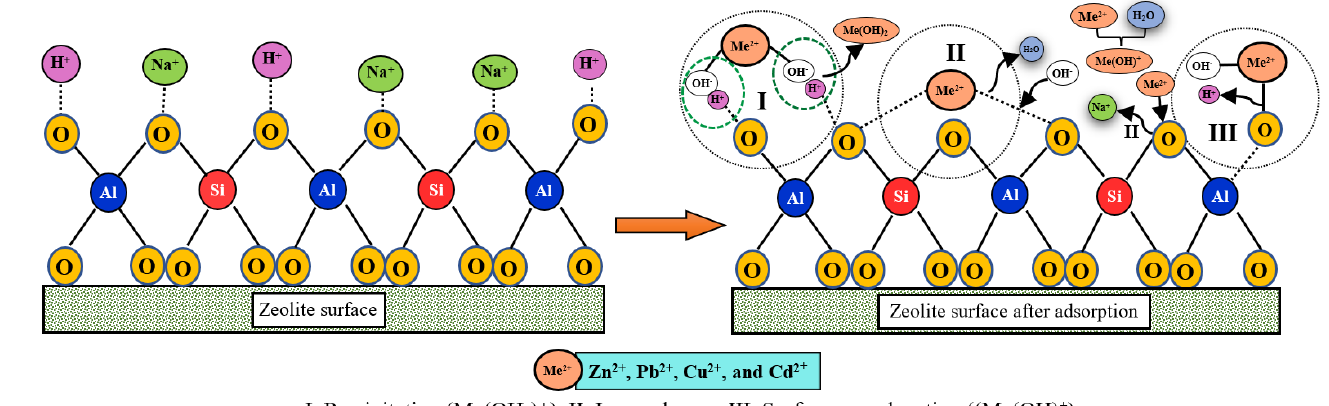
Figure 13. The proposed adsorption mechanism of heavy metal ions on synthesized zeolite.